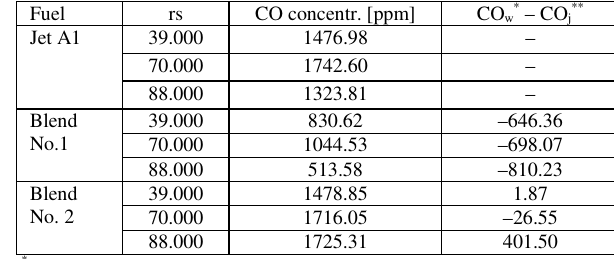
Table 3. The average results of measurements of CO concentration in exhaust